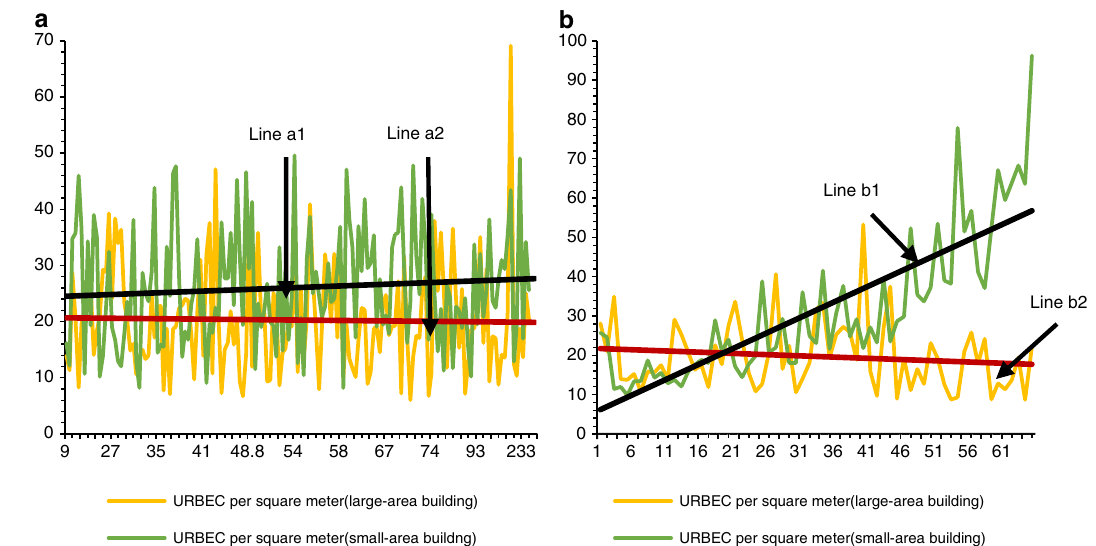
Fig. 3 Comparison of the energy intensity between small and large residential buildings. All buildings in group ( a ) have adopted the BESD, and all the buildings in group ( b ) have not adopted the BESD. Lines a1 and b1 are the trend lines of the URBEC per square meter for small residential buildings. Lines a2 and b2 are the trend lines of the URBEC per square meter for large residential buildings. The x -axis of fi gures a and b represents the difference in the building area ( D -value) between the matched pairs. The y-axis of fi gures a and b represents the URBEC per square meter of the matched